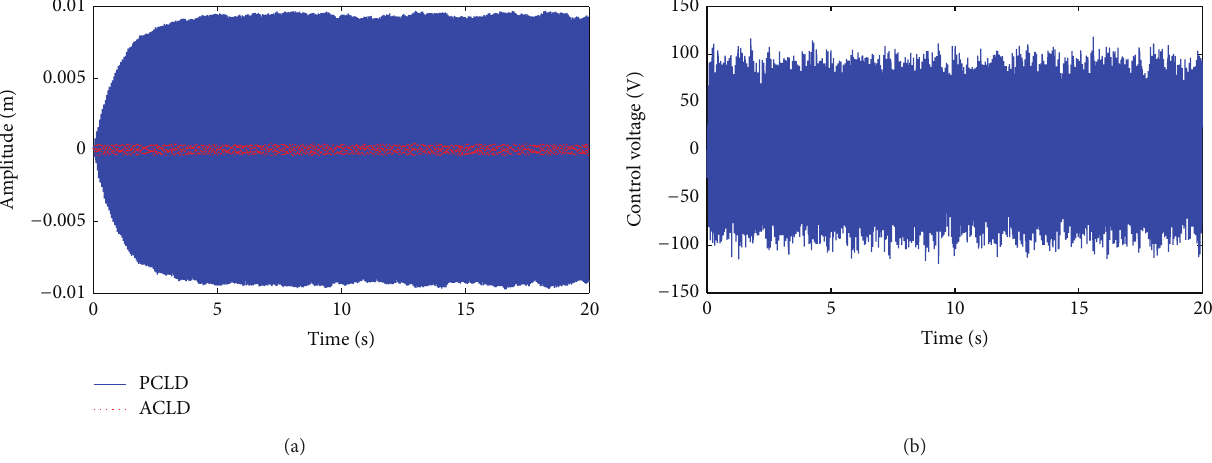
Figure 8: The displacement response for a mixed disturbance using the LQG feedback controller: (a) the displacement response, (b) the control